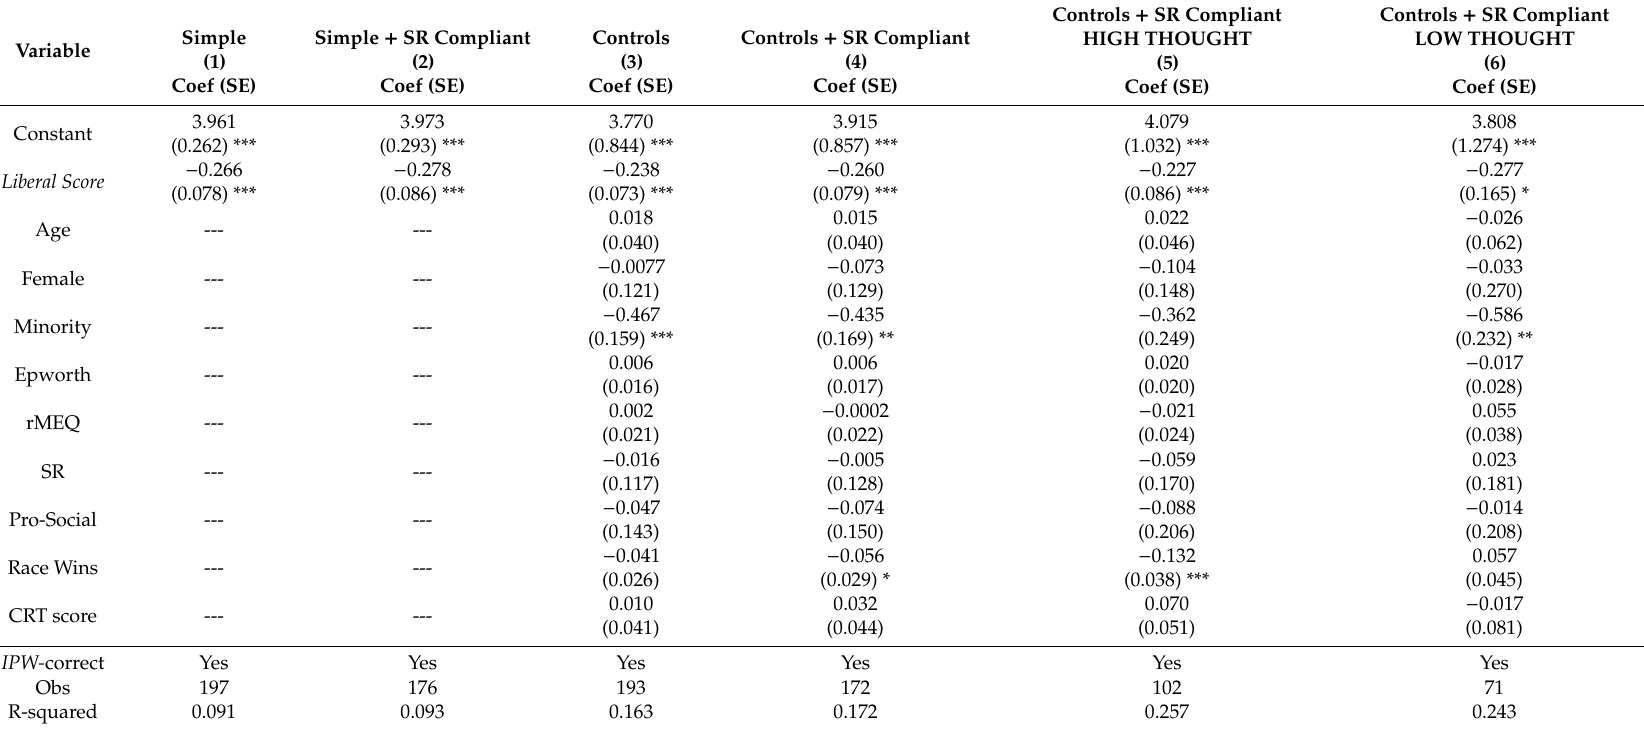
Table 2. Impact of Liberal Score on # PRO-GUN-RIGHTS CLIPS viewed—all